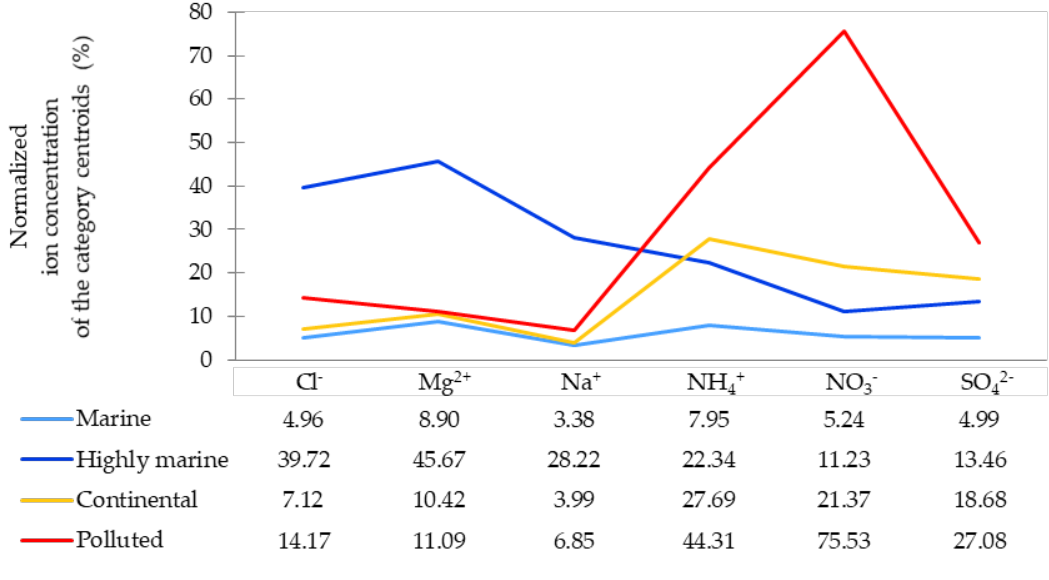
Figure 2. Profile plot established by the AHC from the six main inorganic ions (Na + , Cl − , Mg 2+ , SO 42− , NH 4 + , and NO 3 − ). The Y axis displays the normalized (([Cl − ] − [Cl − ] min ) / ([Cl − ] max − [Cl − ] min )) ion concentrations of the category centroids.